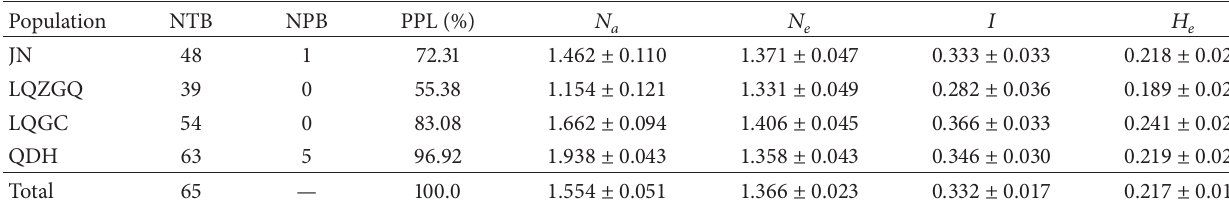
Table2:Thenumberoftotalbands(NTB)andprivatebands(NPB)inrespectivepopulation,percentageofpolymorphicloci(PPL),estimated allele frequency with number of different alleles ( 𝑁 𝑎 ), number of effective alleles ( 𝑁 𝑒 ), Shannon’s Information Index ( 𝐼 ), and expected heterozygosity ( 𝐻 𝑒 ) in O. fragrans .